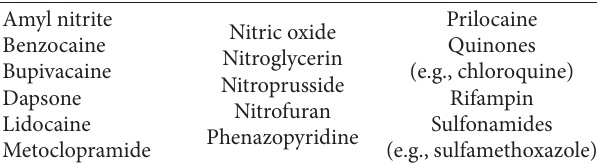
Table 1: Drugs known to induce methemoglobinemia (not inclu- sive) [1, 2].